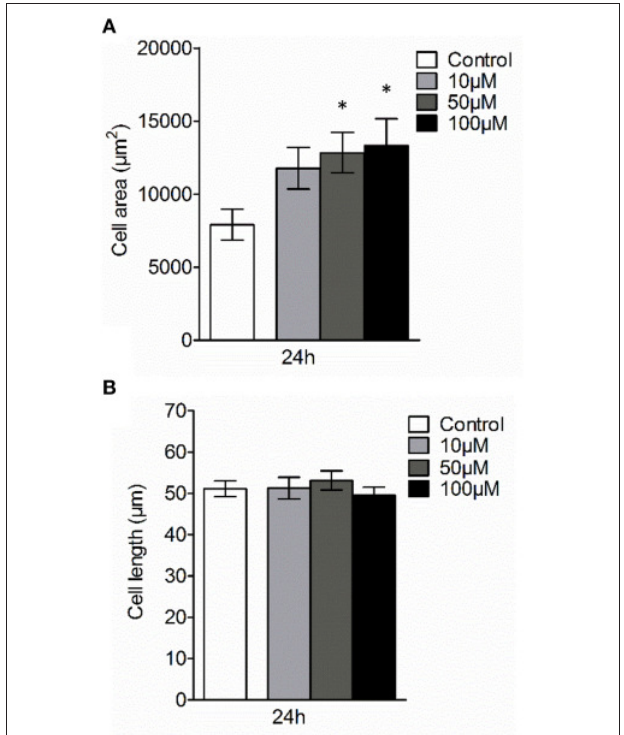
FIGURE 6 | Effect of 3O-C 12 -HSL on AQP9-related cell size of macrophages. Cell were either treated with diluent 0.02% DMSO (Control) for 24h, or stimulated with 10, 50, and 100 µ M 3O-C 12 -HSL for 24h, stained for AQP9, analyzed by LSCM as shown in Figure 4A . (A) Quantification of AQP9-related cell area. (B) Quantification of the approximate cell length of AQP9-stained macrophages (measured as indicated by white arrow in Figure 4A in the direction of polarization). Columns represent the means ± SE. Data from at least four different experiments performed on separate days from six different donors, and at least 100 cells in total per condition. Significant differences are indicated with * when P < 0.05, as analyzed by one-way ANOVA and Dunnett’s multiple comparison